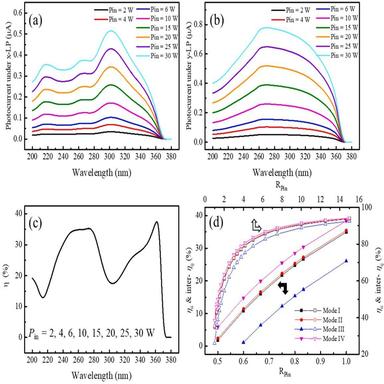
Photocurrent of MGPIN structure under (a) x-LP and (b) y-LP with different incident light powers. (c) The electrical anisotropy η of MGPIN when Pinx = Piny. (d) The changes of electrical anisotropy inter-ηij with different Rpin= Pinx / Piny.